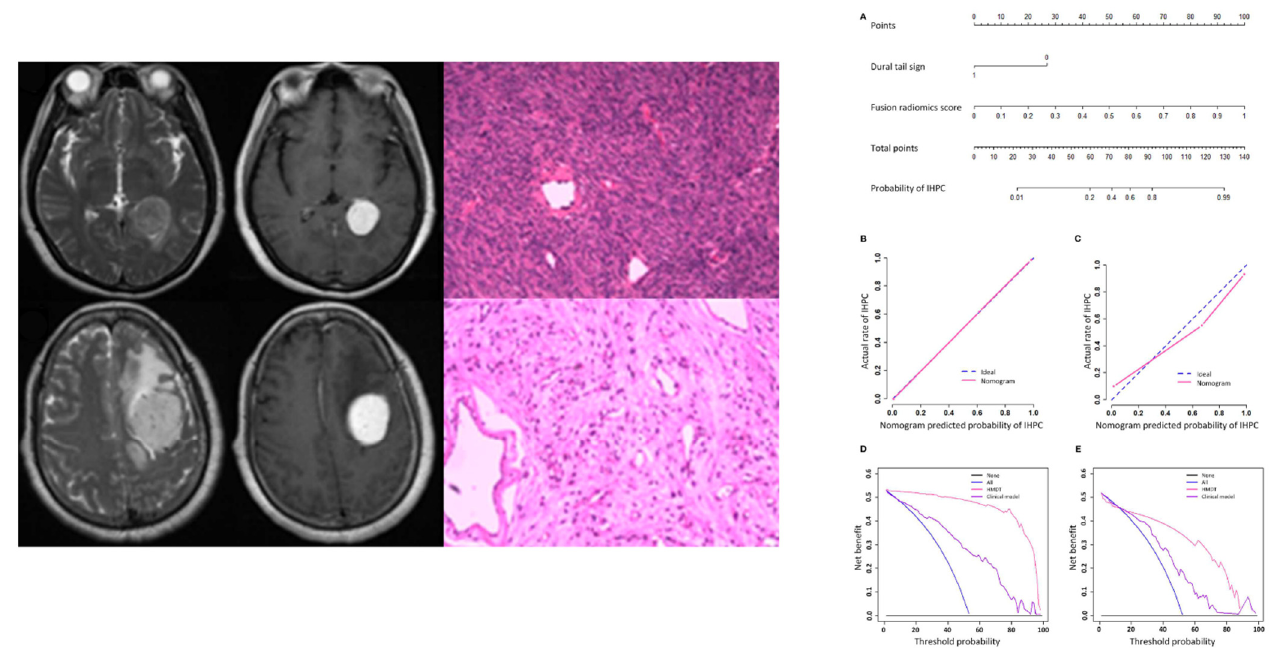
Figure 2. MR and pathological images of a hemangiopericytoma (upper row) and a meningioma (lower row). Nomogram ( A ), calibration curves ( B,C ), and decision analysis curves ( D,E ) in the training and validation cohorts for differential diagnosis between the two conditions. IHPC: intracranial hemangiopericytoma; HMDT: IHPC and Meningioma Diagnostic Tool. Adapted from Ref. [20],